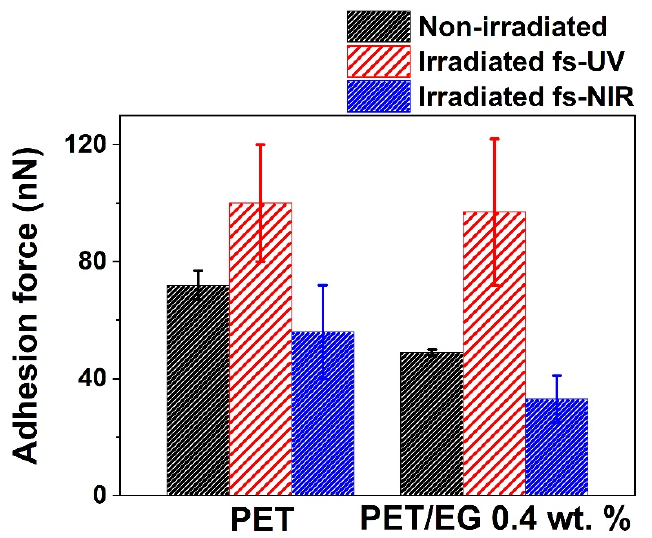
Figure 7. Adhesion force determined by the colloidal tip technique. The data shown correspond to the average and standard deviation of three measurements.